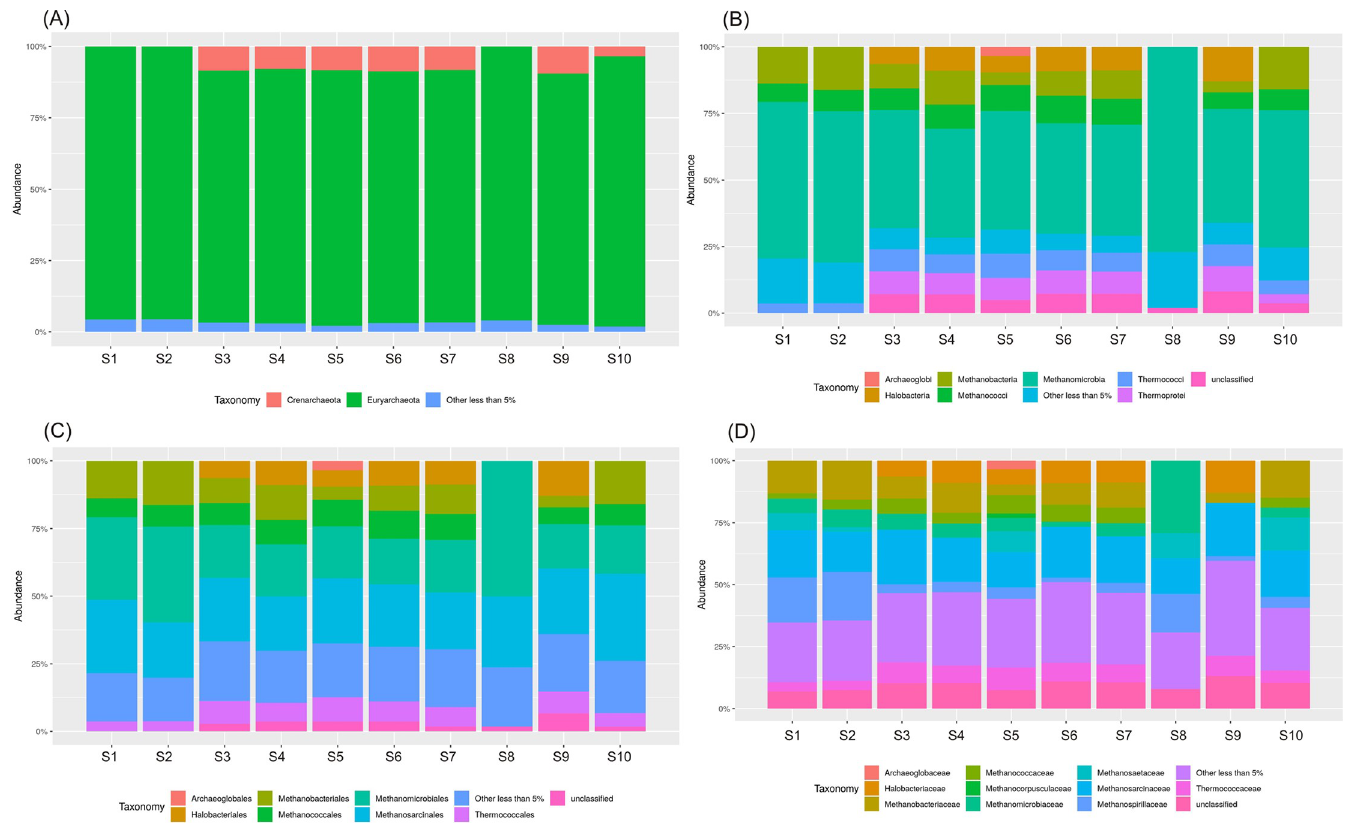
Fig 5. Changes of archaeal community composition at the (A) phylum, (B) class, (C) order, (D) family levels in the different stages of technological